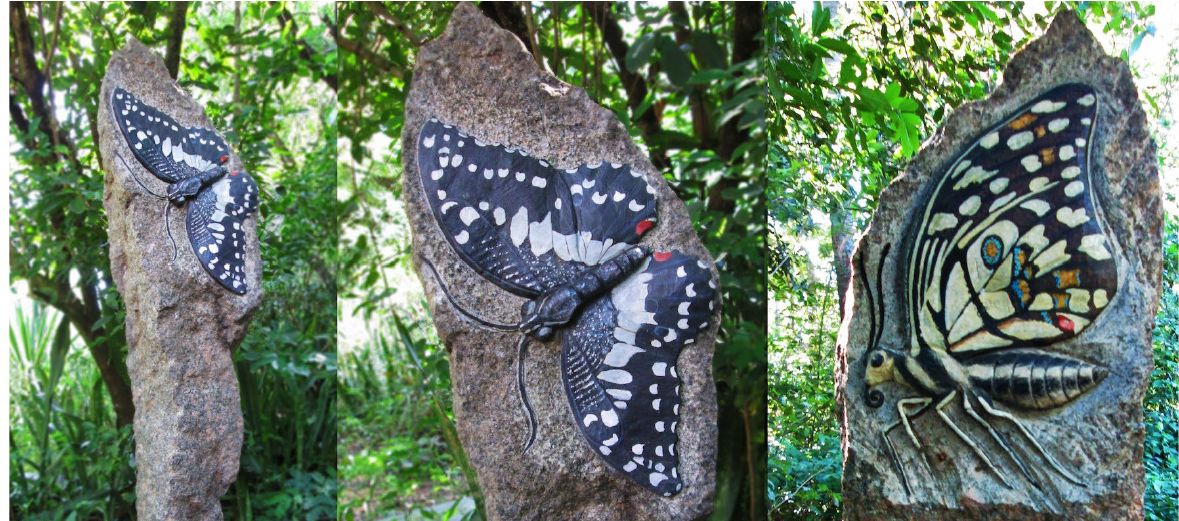
Image 2. Two-dimensional carving and painting of a Common Lime Butterfly Papilio demoleus on an oddly-shaped pillar. Sometimes one comes upon oddly-shaped pillars like this and we usually find a subject to suit it. So, occasionally, the shape and size of the pillars influence the design. The reverse side of the pillar has the same species in a resting posture. Pitchandikulam, Auroville.